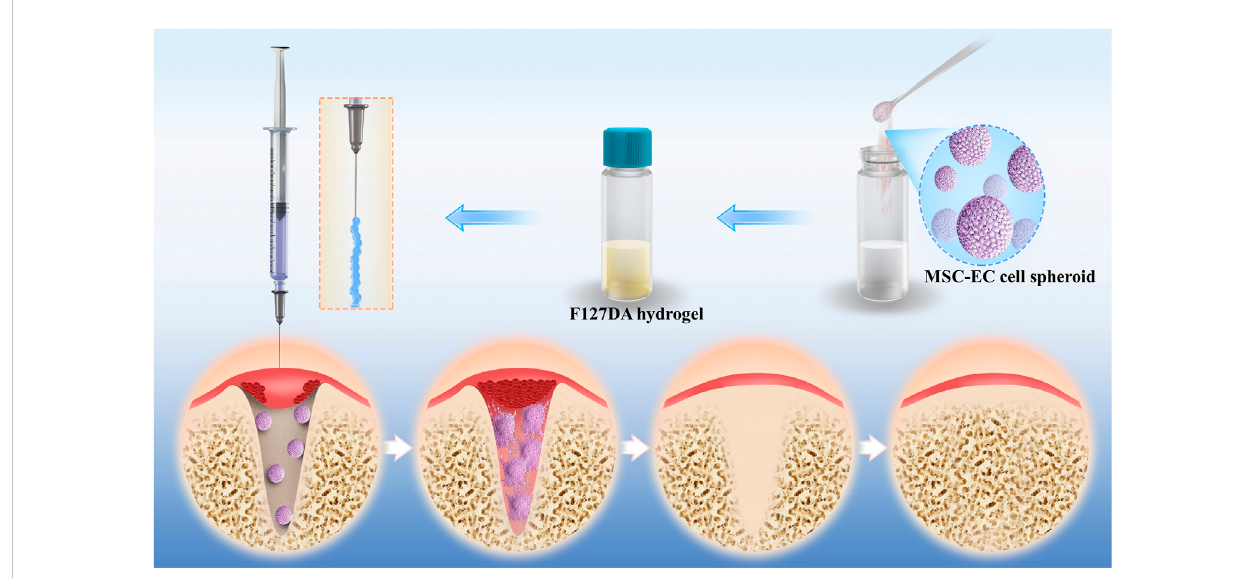
FIGURE 1 Schematic illustration of F127DA hydrogel loading with MSC-EC spheroids promoting tooth extraction socket healing.